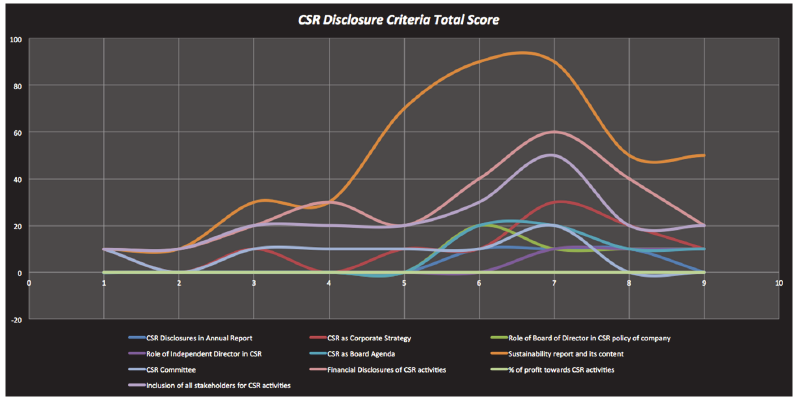
Fig. 3. Graphical Presentation - CSR Disclosure of All 13 Insurance